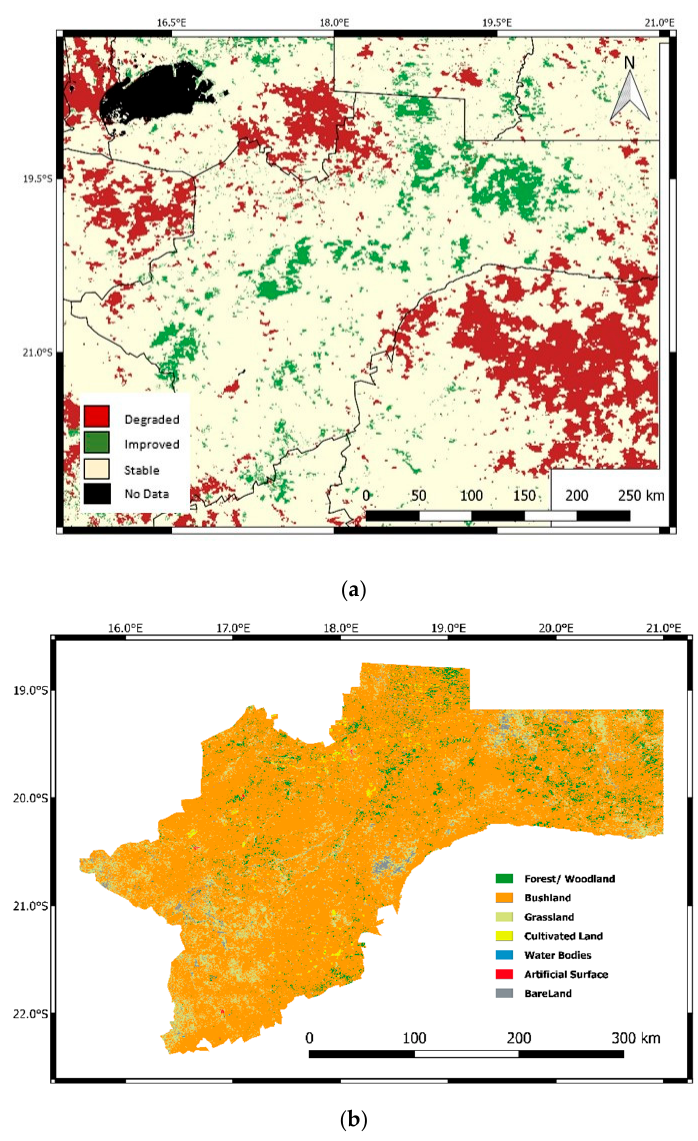
Figure 16. Comparison Land Degradation Map between 2001 and 2015 with ( a ) own calculation with Trends.Earth, and ( b ) bush encroachment areas in Otjozondjupa 2016 [61].